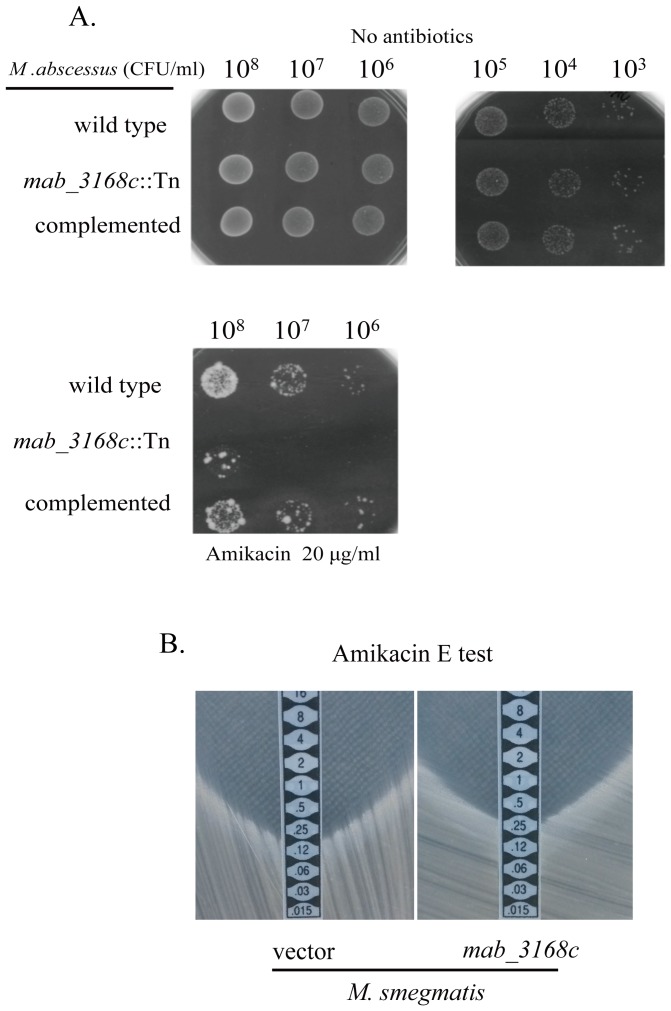
Contribution of mab_3168c to aminoglycoside resistance.(A) Anti-mycobacterial effects of amikacin against various M. abscessus strains were determined by plating indicated number of cells on 7H11 agar plates. The experiments were repeated 3 times. One representative picture of each of the 3 days old cultures without antibiotics and the 5 days old cultures with antibiotics is shown. (B) Amikacin susceptibility of M. smegmatis containing pYUB412A (vector) or pYUB412A-mab_3168c (mab_3168c) was examined by the E test. The experiment was repeated 3 times. One representative picture of the E test of each of the 5 days old cultures is shown.